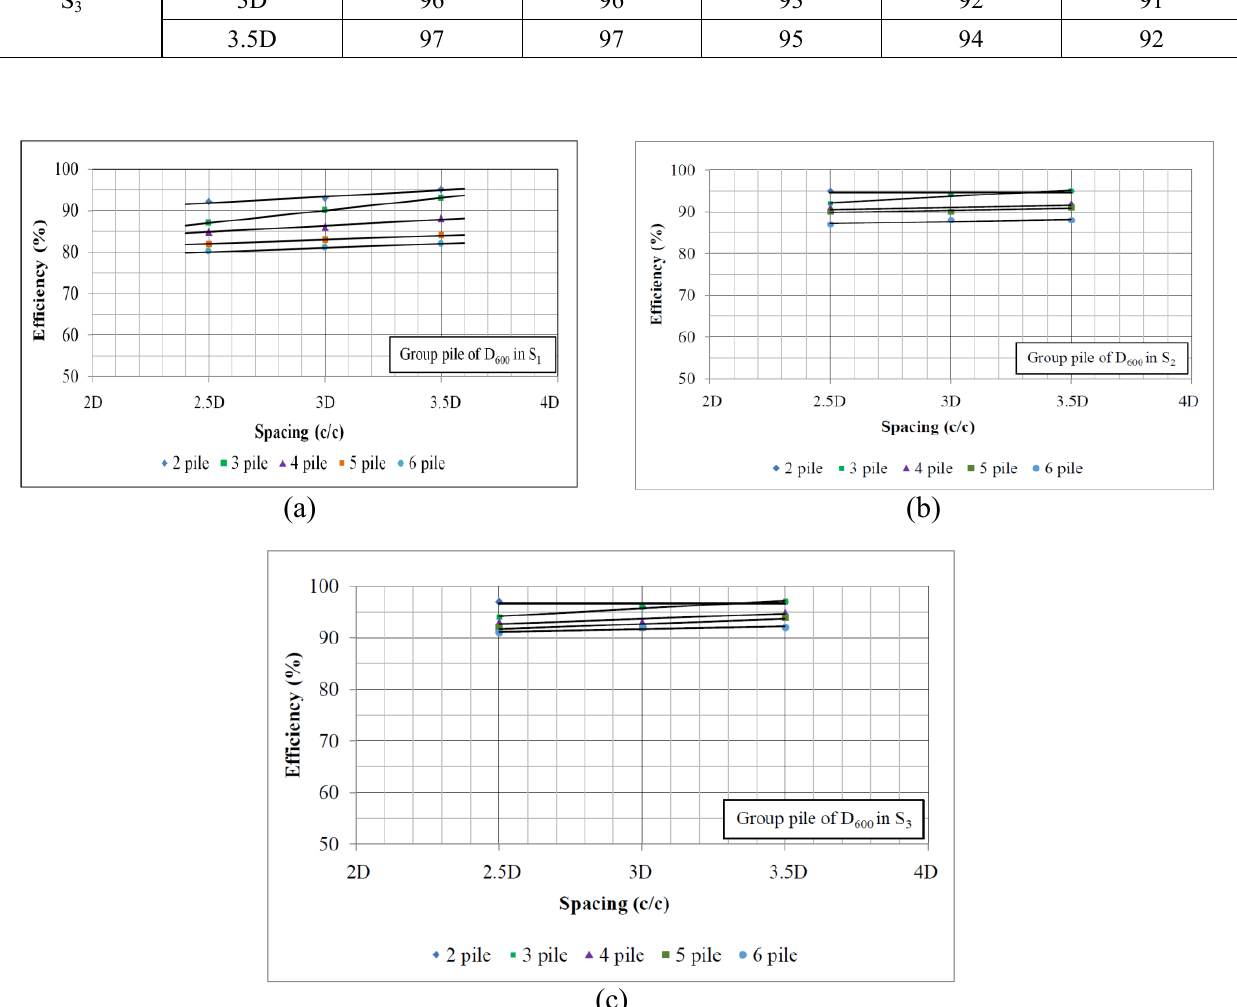
Fig. 4. Efficiency of group piles under different pile spacing in (a) soil S